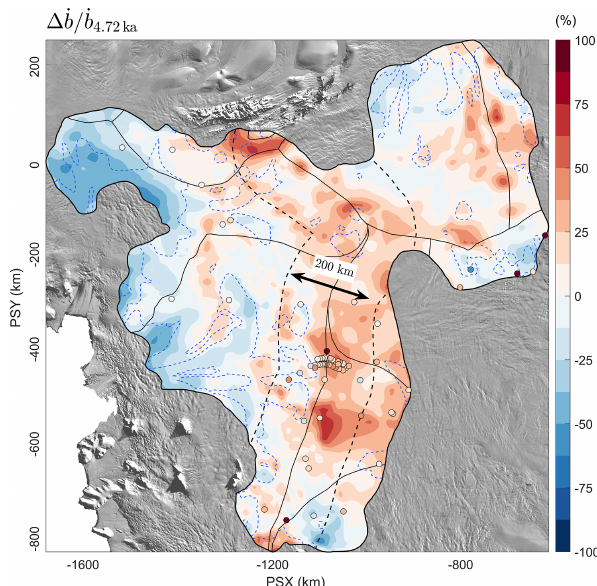
Figure 4. Relative change in accumulation rates between the 4.72ka-to-present estimates and modern rates. The points on the map represent the relative change in ice-equivalent accumulation rate between the nearest grid cell in the 4.72ka-to-present grid and the 79 modern observations from cores (Figs. 1 and S6; Sect. 2.4). The dashed black outline line represents the 100km boundary on either side of the Amundsen–Weddell–Ross Divide used to provide the summary statistics in Sect. 3.1 and Table 2. The dashed blue line shows the contours of the upper limit of the interquartile range for the D parameter ( D ≤ 0 . 34), whereby all values situated inside of this boundary may satisfy the D (cid:28) 1 criteria and those outside may require re-evaluating with the use of multi-dimensional mod- els (Sect. 2.2.1–2.2.2). The background image is the 2014 MODIS mosaic of Antarctica (Haran et al.,